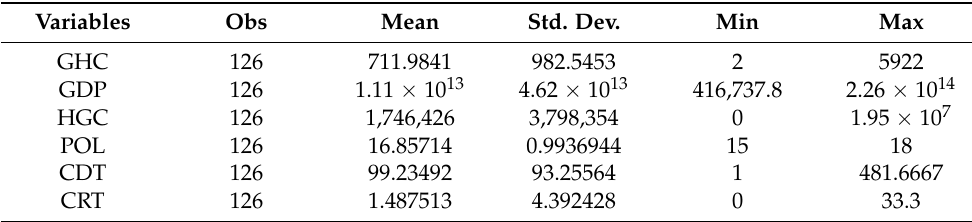
Table 3. Descriptive statistics.